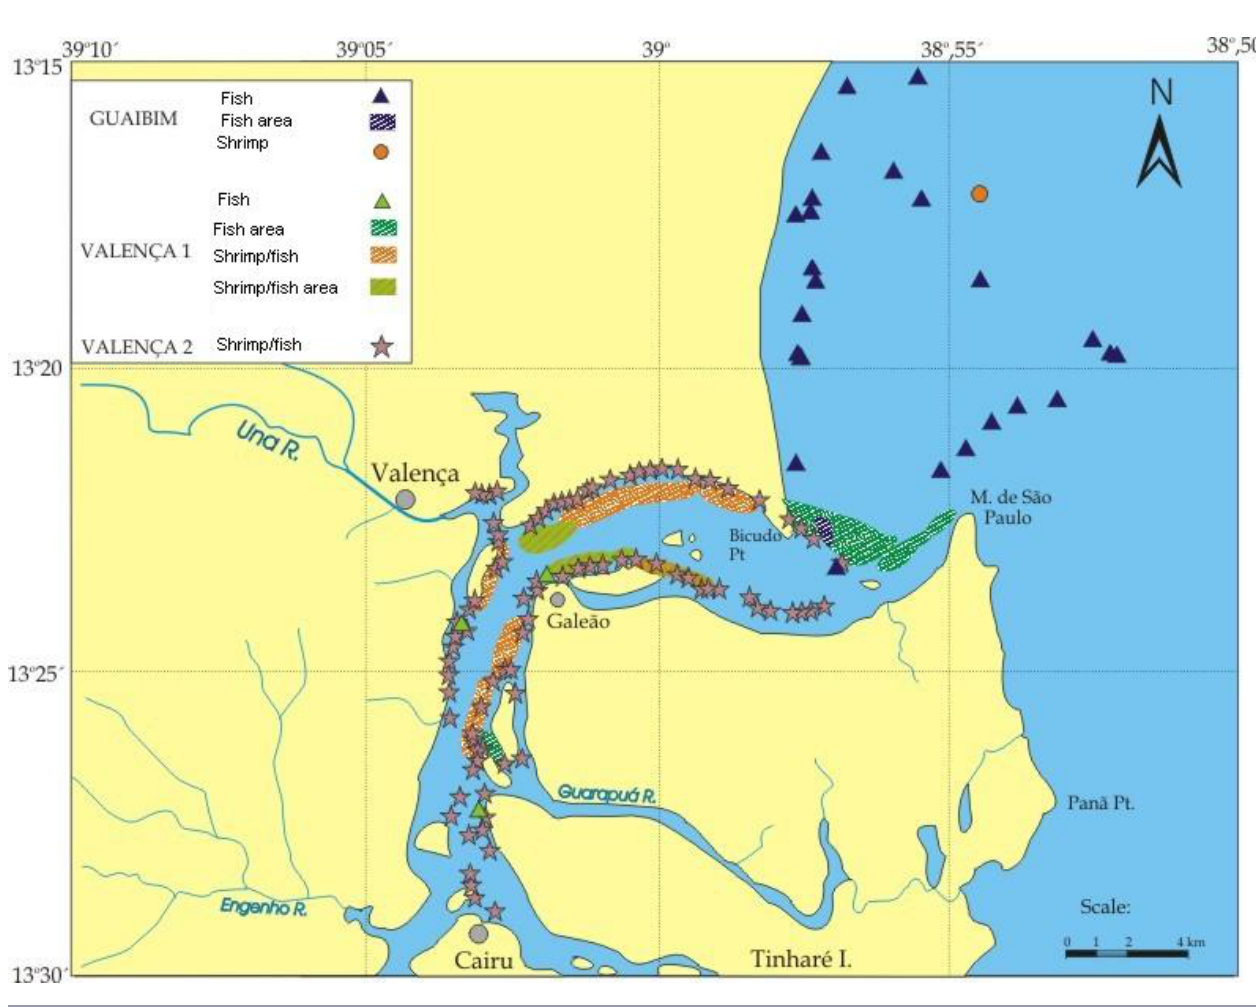
Fig. 4 . Fishing spots marked by two informants in Valença, Bahia State, sites Valença 1 and 2, and Guaibim, Bahia State in